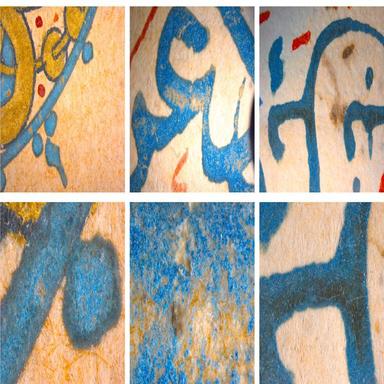
Macro (up) and micro (down) details of three different shades of blue found in Prophet biography: a bright blue, intense blue and a blue were a thin layer of varnish (colored glaze), or another color was applied. As the blue is found extensively detaching from the support it is possible that the bright and intense blue also had a 'glaze', that was lost over time.